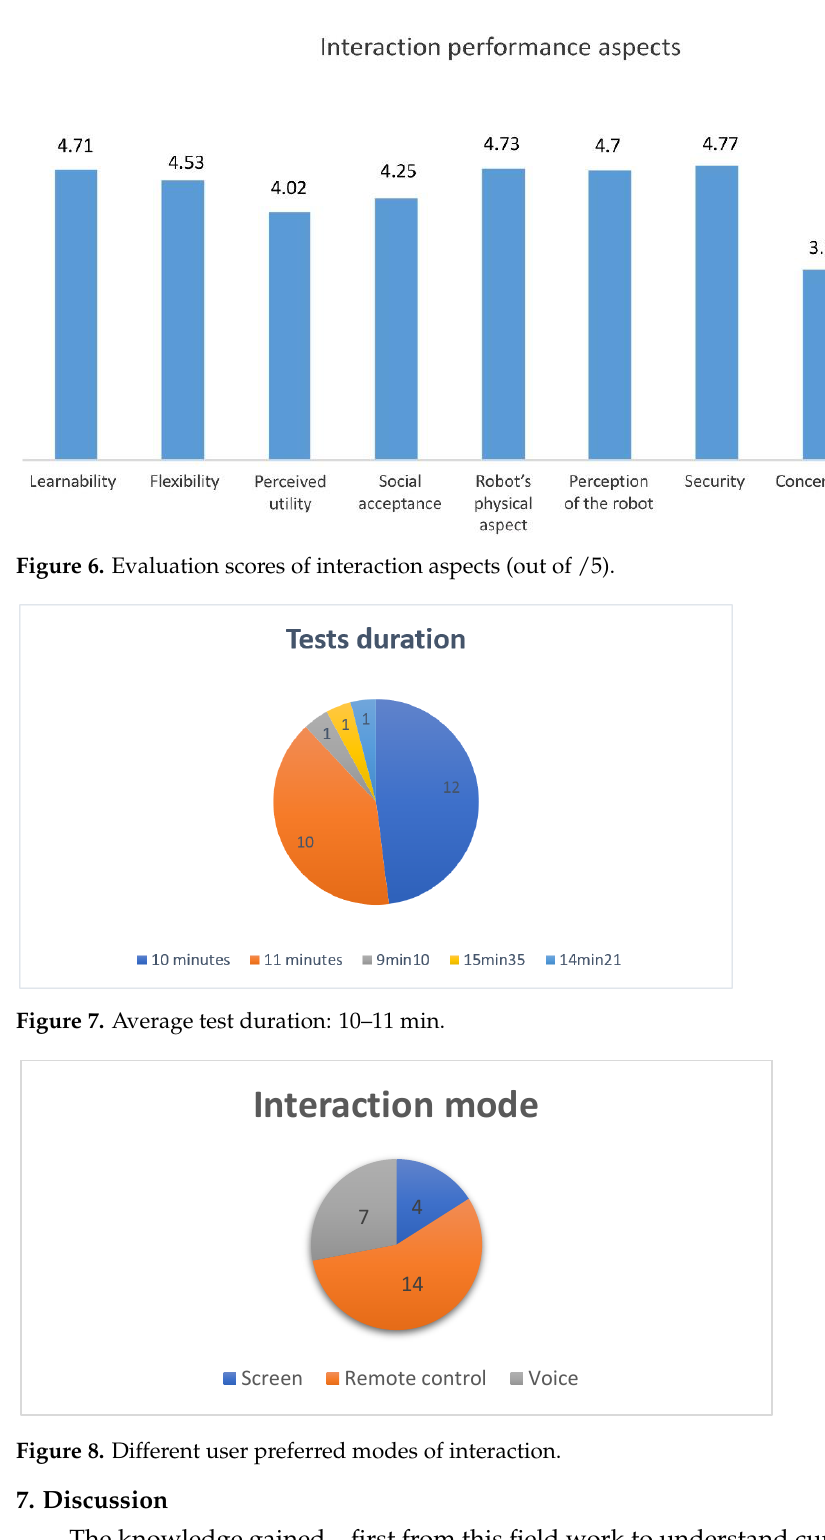
Figure 8. Different user preferred modes of interaction .